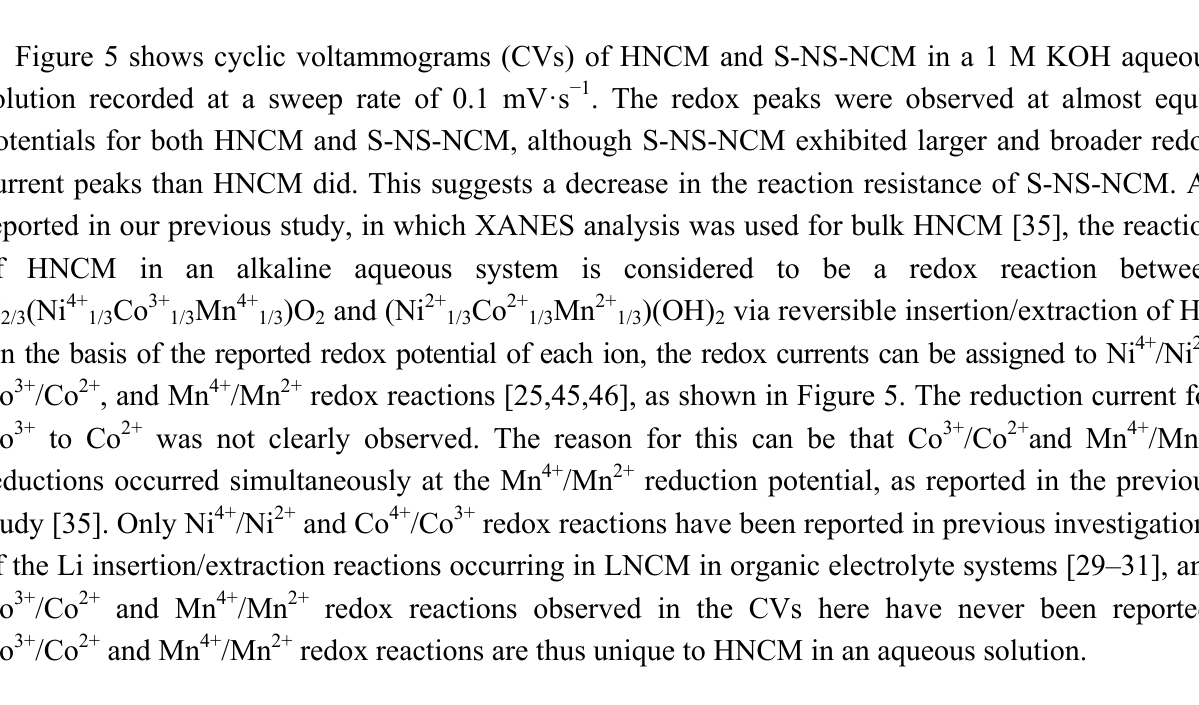
Figure 5. Cyclic voltammograms of HNCM and S-NS-NCM at a sweep rate